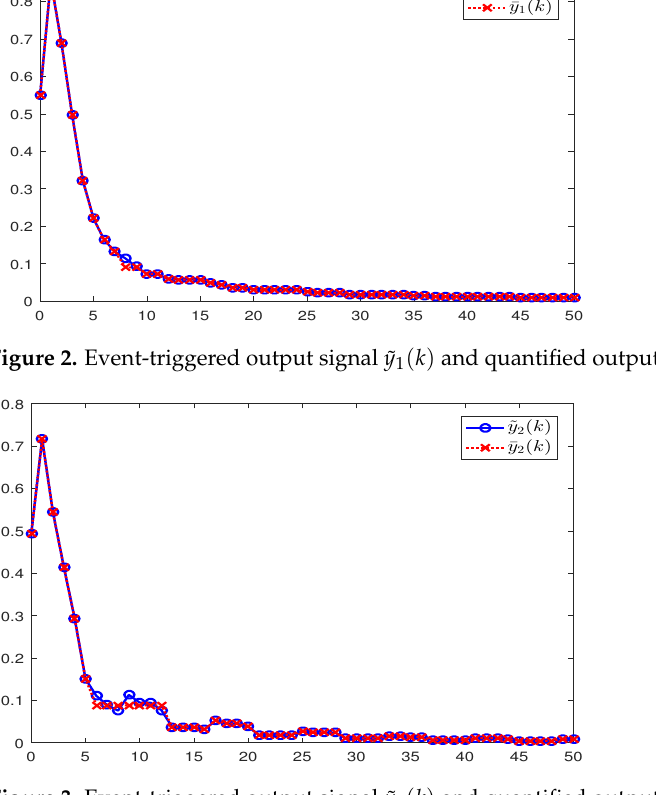
Figure 3. Event-triggered output signal ˜ y 2 ( k ) and quantified output signal ¯ y 2 ( k ) .